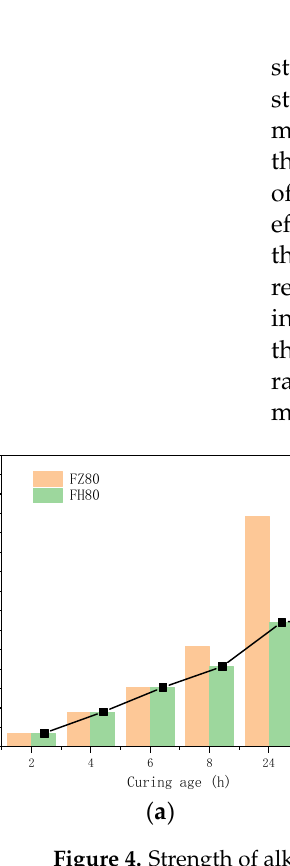
Figure 4. Strength of alkali-activated mortar under oven and steam curing conditions: ( a ) FH; ( b ) GH; ( c ) MH.